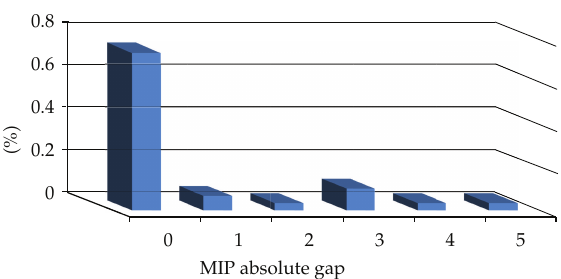
Figure 2: Frequency of the results in the range for 30 real instances within the specified computation time.